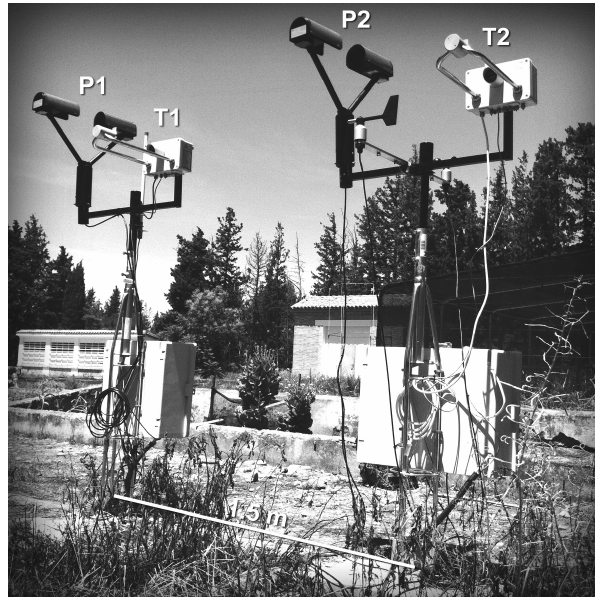
Figure 1. Sampling site with four collocated disdrometers: two Parsivel 2 (P1 and P2, with serial numbers 304555 and 304553); and two Thies (T1 and T2, with serial numbers 0436 and